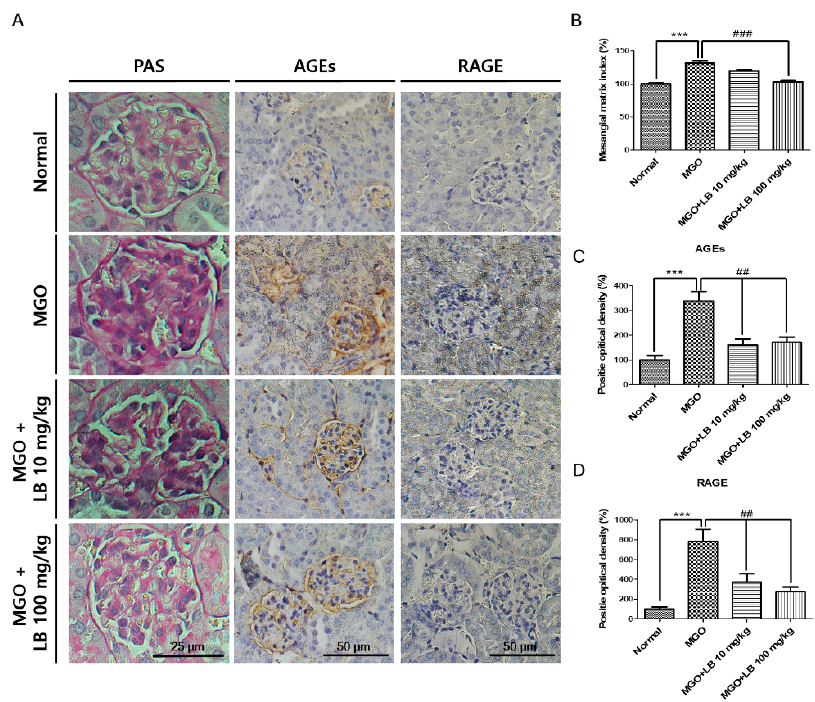
Figure 7. Immunohistochemical (IHC) and PAS staining of kidney tissues from MGO-treated